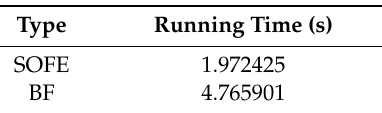
Figure 11. Simulation results of local measurement fusion estimation in each cluster: ( a ) Tank1, ( b ) Tank2, ( c ) Tank3. Table 2. The running time of the sequential observation fusion estimator (SOFE) algorithm and the general weighted batch fusion (BF)